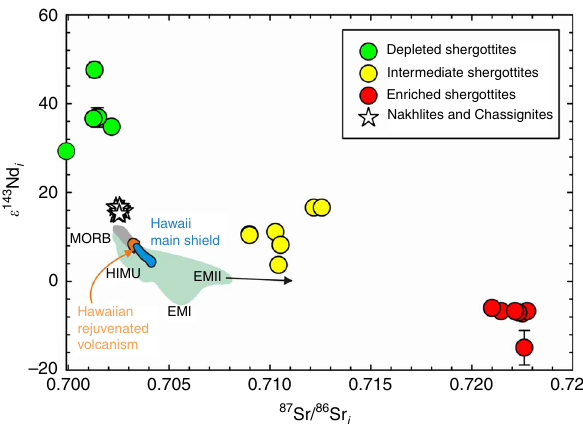
Fig. 1 Comparison of the strontium and neodymium isotopic compositions of basaltic volcanic rocks at the time of their crystallization ( i = initial crystallization time) from Mars and Earth. Terrestrial basalts include ocean island basalts (green fi eld), mid-ocean ridge basalts (MORB; gray fi eld), Hawaiian Main Shield (Mauna Loa, Mauna Kea; blue fi eld), and Hawaiian Rejuvenated Volcanism (Honolulu volcanics, North Arch, Niihau, Kaula; orange fi eld). Approximate terrestrial “ HIMU ” (high 238 U/ 204 Pb), EMI